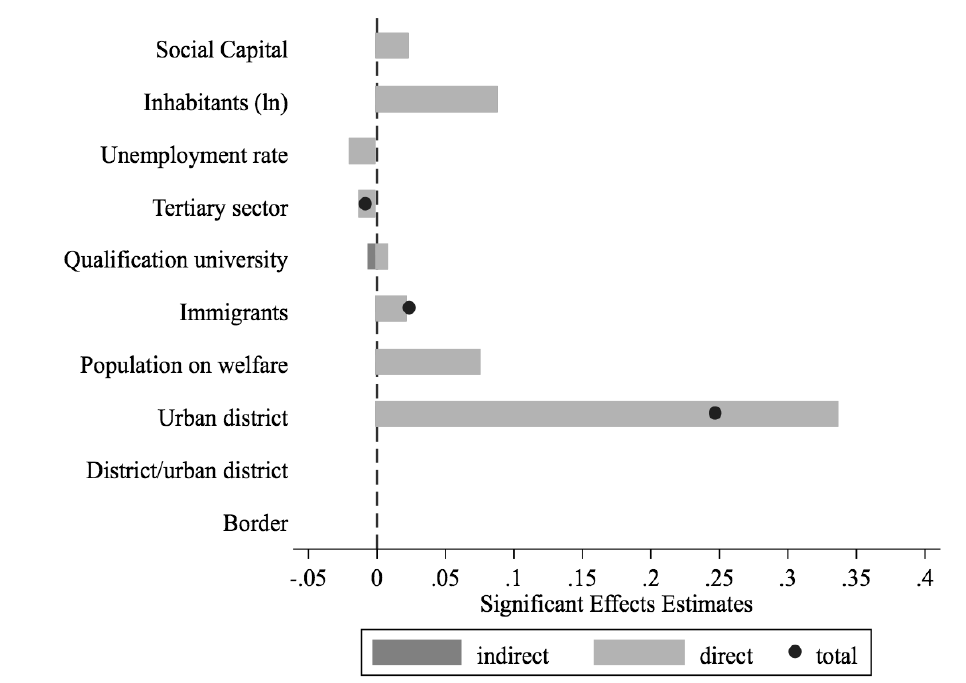
Figure 5: Illustrating significant effects estimates (SDM) of Table 2